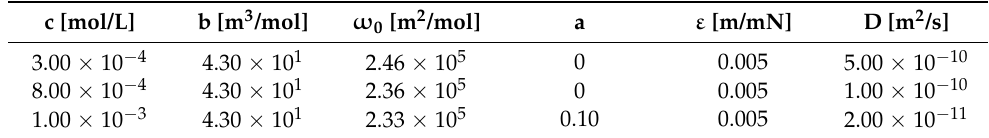
Table 9. Parameter values obtained by fitting the Frumkin adsorption model Equations (1)–(3) and the diffusion Equation (6) to the experimental data of Figure 9 as measured for equimolar solutions of NaC 12 SO 4 + C 6 TAB.